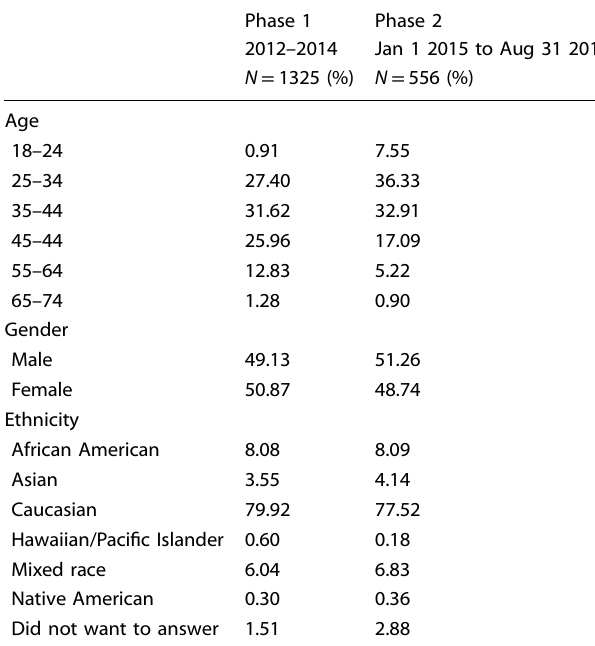
Table 2. CPMC Air Force Clinical Utility Study,